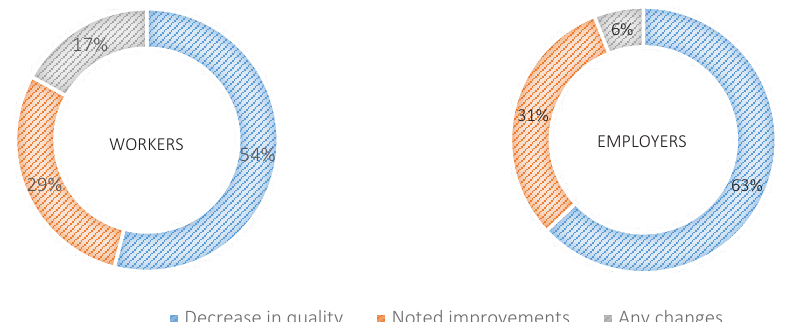
Figure 4. Assessment of the effectiveness of online